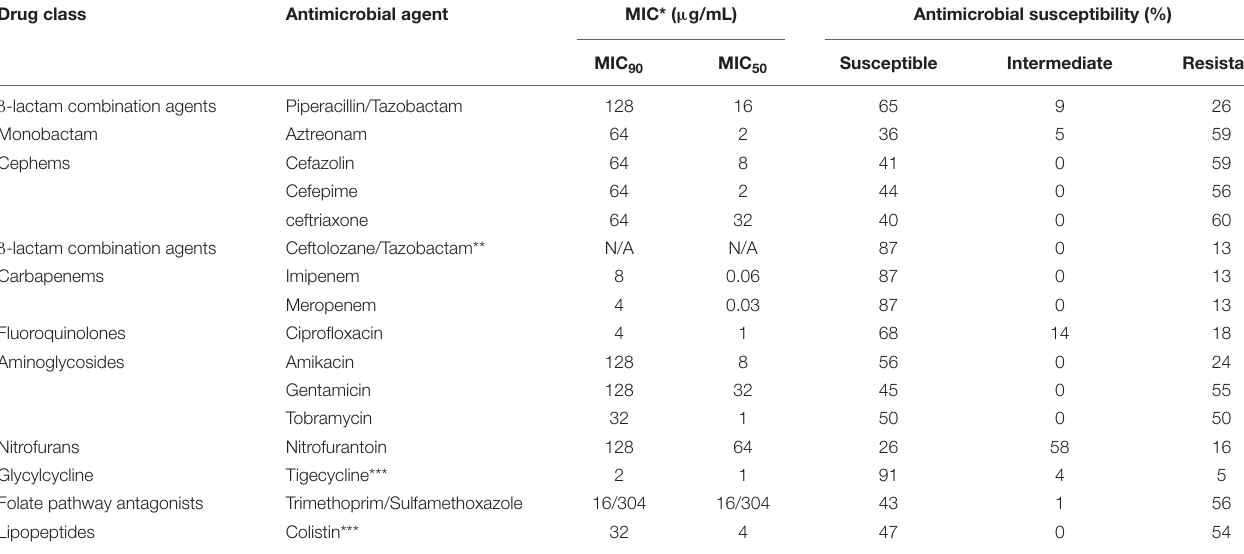
TABLE 2 | Minimum inhibitory concentration data and antimicrobial susceptibility of 80 Klebsiella pneumoniae isolates from January to December 2017 at Hospital Civil de Guadalajara. Drug class Antimicrobial